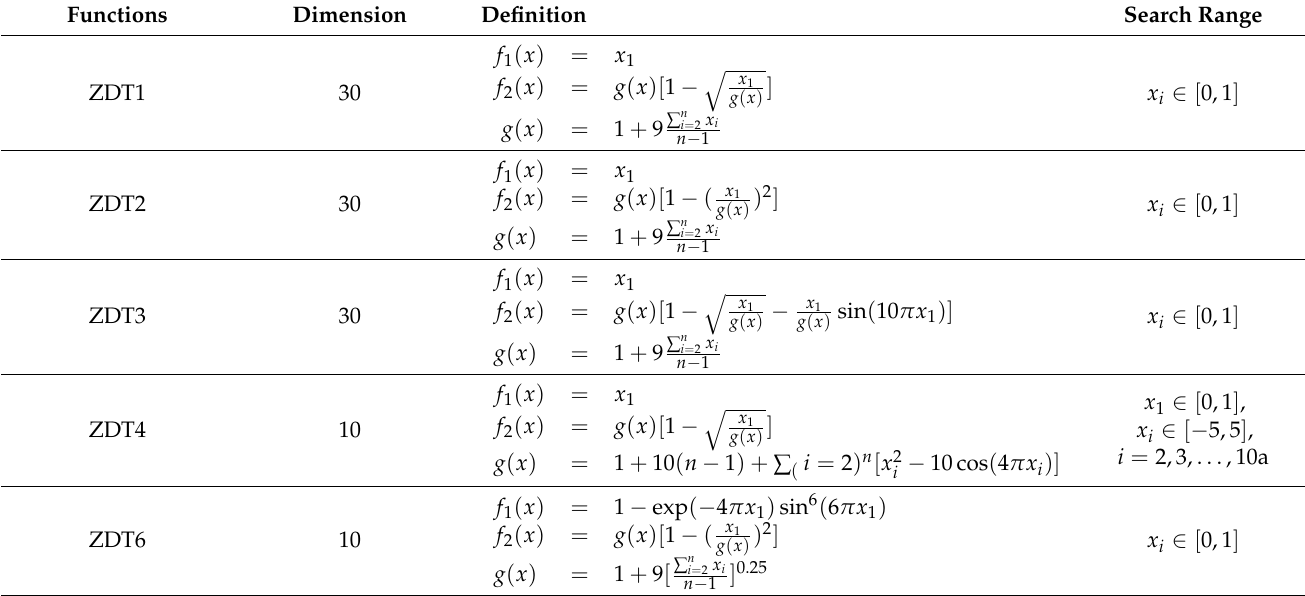
Table 2. Evaluation is conducted using a multi-objective benchmark function. g ( x ) = 1 for the whole Pareto